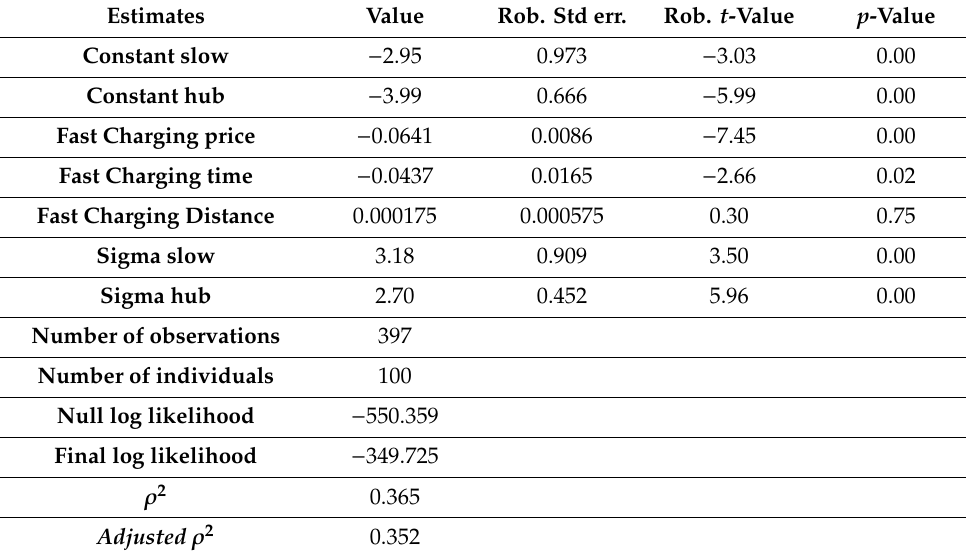
Table 5. Results of mixed logit